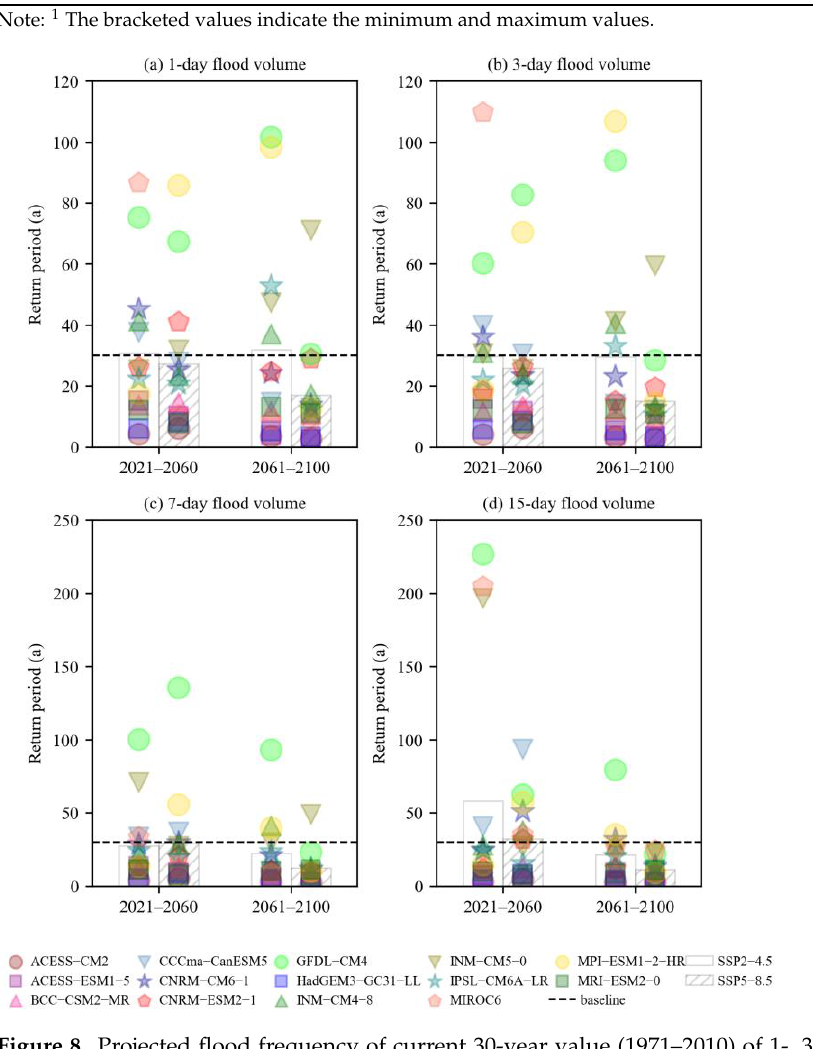
Table 5. Projected changes in flood volume of the 30-year return value of 1-, 3-, 7-, and 15-day floods in the Fujiang River basin for 2021 – 2060 and 2061 – 2100 under 14 GCMs and 2 SSP-RCPs (relative to 1971 – 2010). Scenario